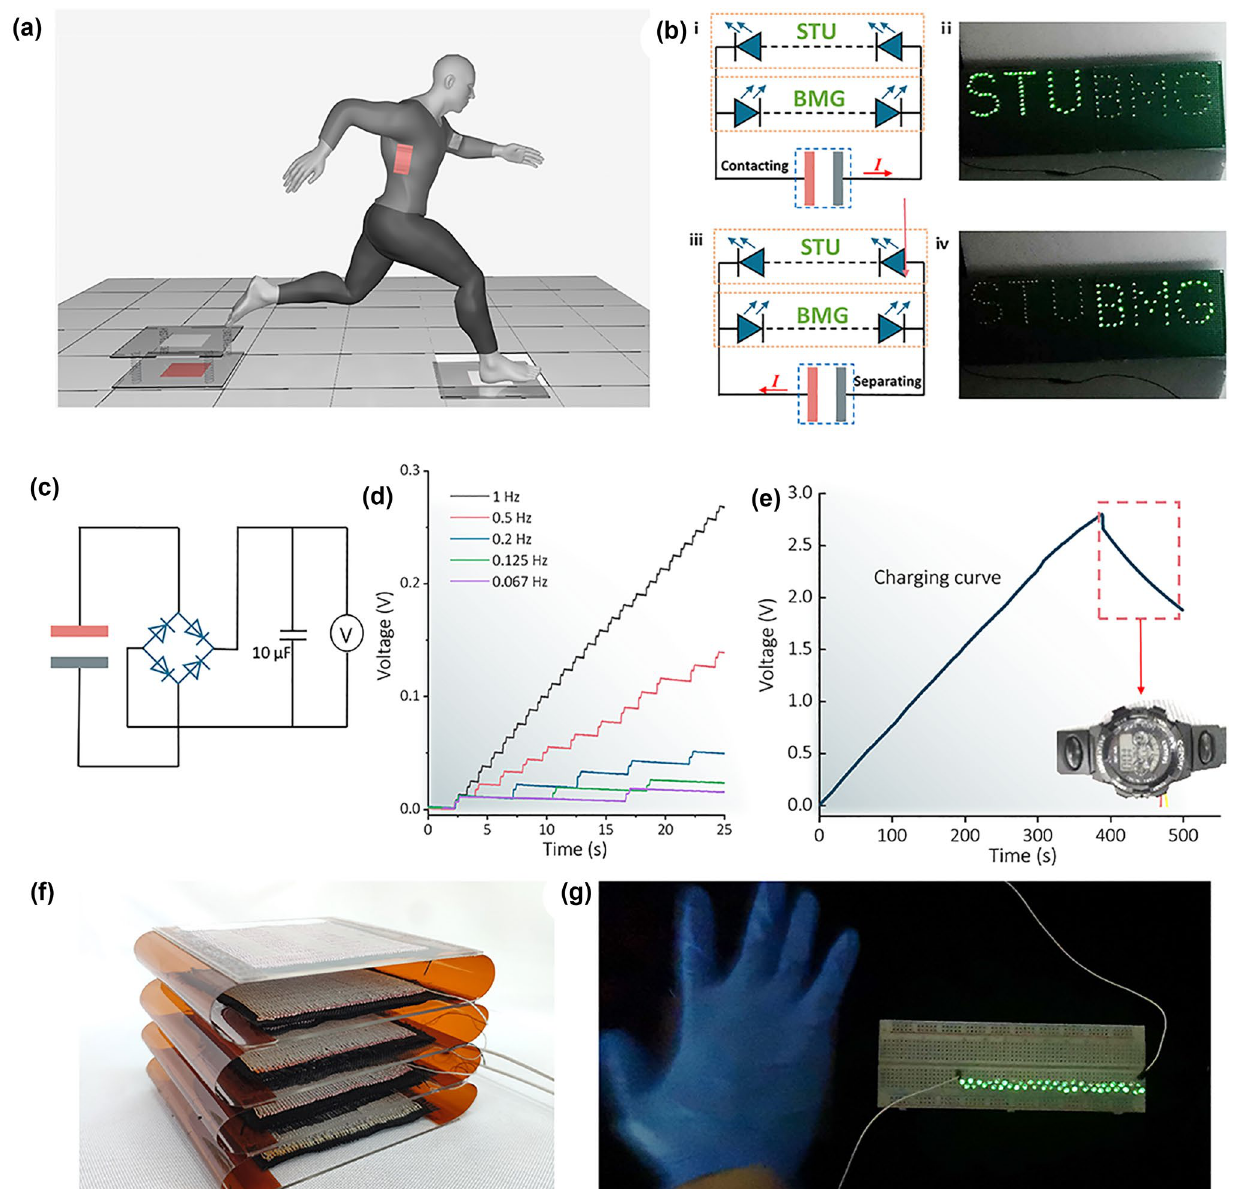
Fig. 8 Applications of EHTs: a Schematic illustration of the use of EHTs as wearable power generation fabrics and floors to harvest energy from human motion. b (i) Schematic diagram of connection between the energy harvesting floor and LEDs shaped into the letters “STU” and “BMG.” (ii) Photograph of the energy harvesting floor driving the LEDs shaped into the letters “STU.” (iii) Schematic diagram of the reversed connection between the energy harvesting floor and LEDs that make up the letters “STU” and “BMG.” (iv) Photograph of the LEDs shaped into the letters “BMG” lighted up by the reversely connected energy harvesting floor. c Circuit diagram of the energy harvesting floor to continuously charge a capacitor of 10 μF with a rectifier. d Measured voltage of a 10-μF capacitor charged by the energy harvesting floor at different frequen- cies. e Charging curve of a 100-μF capacitor charged by the energy harvesting floor at a frequency of 5 Hz. The inset shows the photograph of charged capacitor to power an electronic watch. f Photograph of multilayered EHTs with four-unit numbers connected in parallel. g Photograph of 46 green LEDs connected in parallel powered by the resulting multilayered SF/PTFEF EHTs (ambient humidity: b at 50%, d , e at 37%, and g at 65%) (Color figure